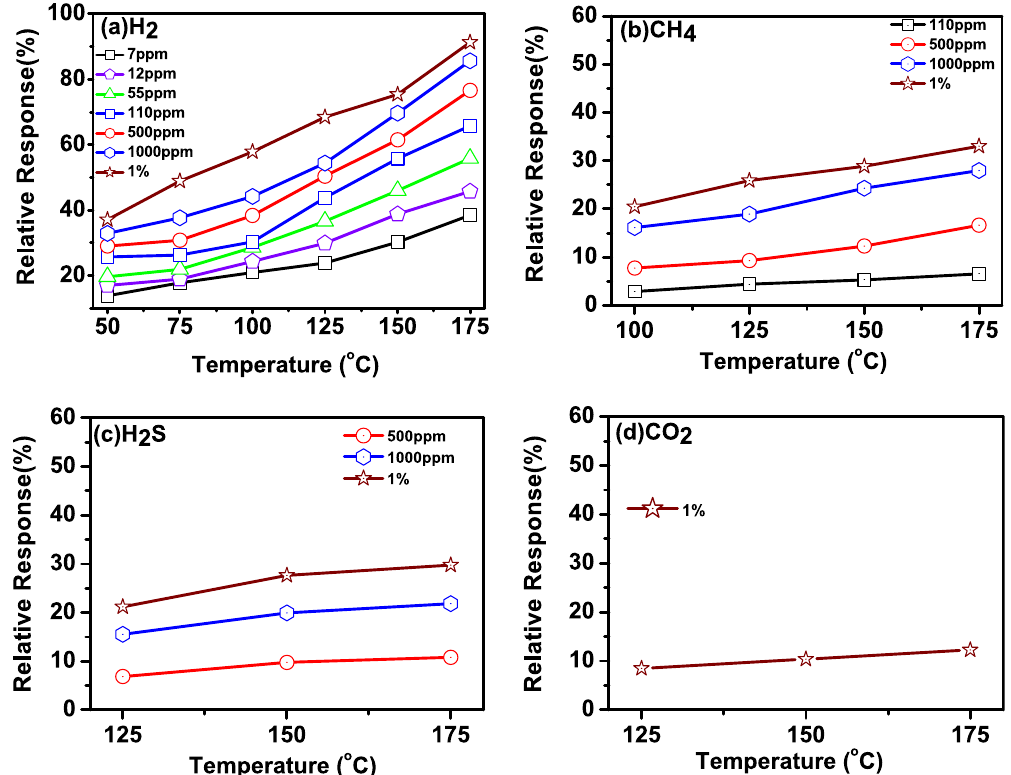
Figure 3. Sensor’s relative response variation with operating temperature and gas